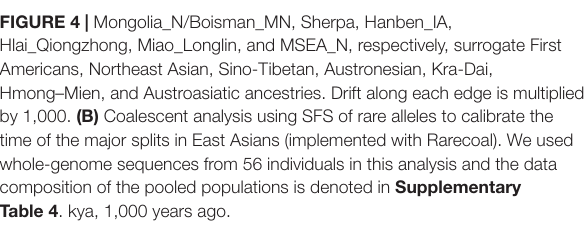
FIGURE 4 | Mongolia_N/Boisman_MN, Sherpa, Hanben_IA, Hlai_Qiongzhong, Miao_Longlin, and MSEA_N, respectively, surrogate First Americans, Northeast Asian, Sino-Tibetan, Austronesian, Kra-Dai, Hmong–Mien, and Austroasiatic ancestries. Drift along each edge is multiplied by 1,000. (B) Coalescent analysis using SFS of rare alleles to calibrate the time of the major splits in East Asians (implemented with Rarecoal). We used whole-genome sequences from 56 individuals in this analysis and the data composition of the pooled populations is denoted in Supplementary Table 4 . kya, 1,000 years